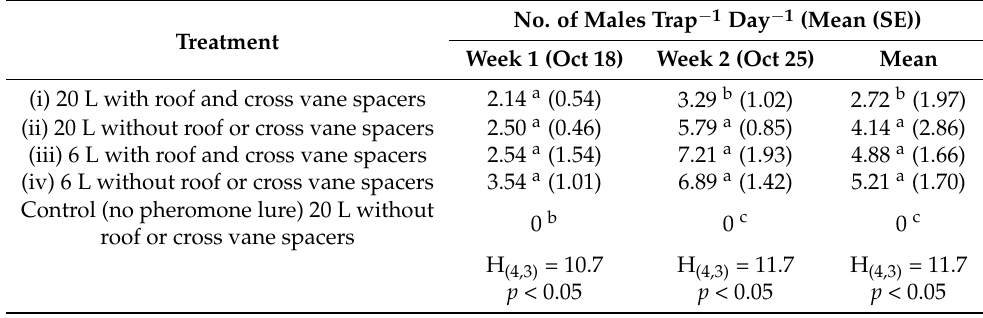
Table 1. Captures of male Chilecomadia valdiviana moths in different types of white bucket traps in an apple orchard during the 2016 season in the Maule Region,